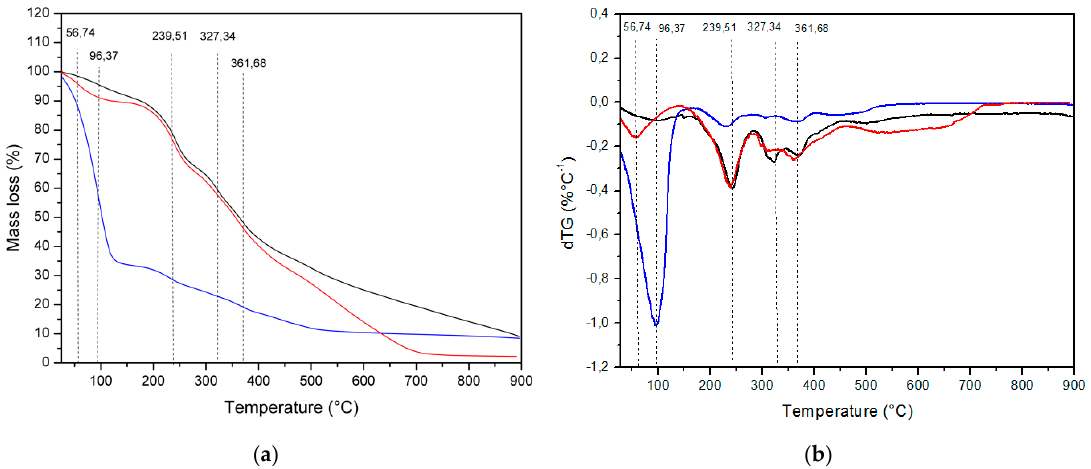
Figure 1. Thermogravimetric curve (TG) analysis ( a ) and for derivative weight dTG ( b ) of dehydrated samples of BRS magna grape skin residue using conventional oven-drying and freeze-drying methods. The profiles shown as blue, red, and black lines represent the fresh skin, conventional oven-drying, and freeze-drying processes, respectively.